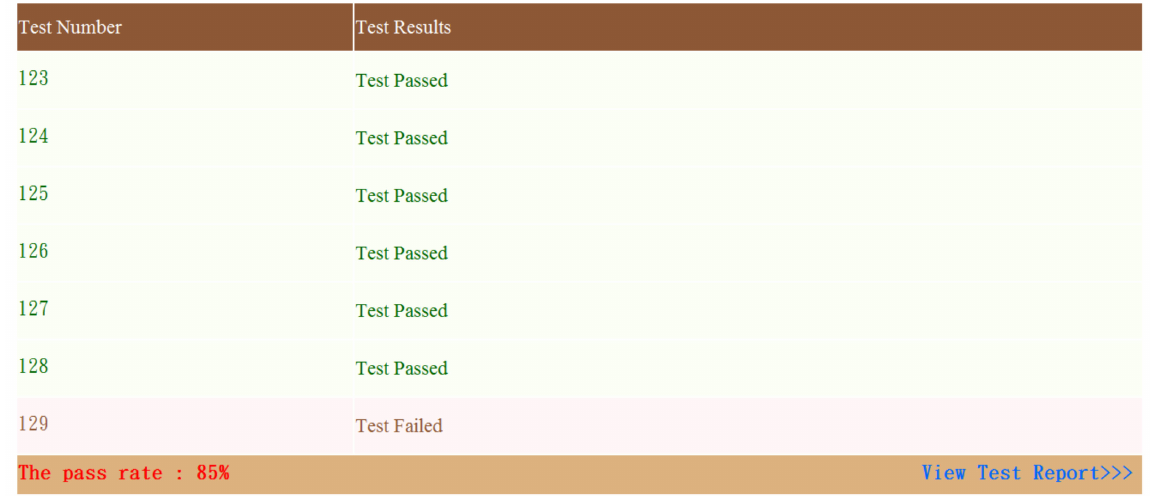
Figure 9. Test result (1).